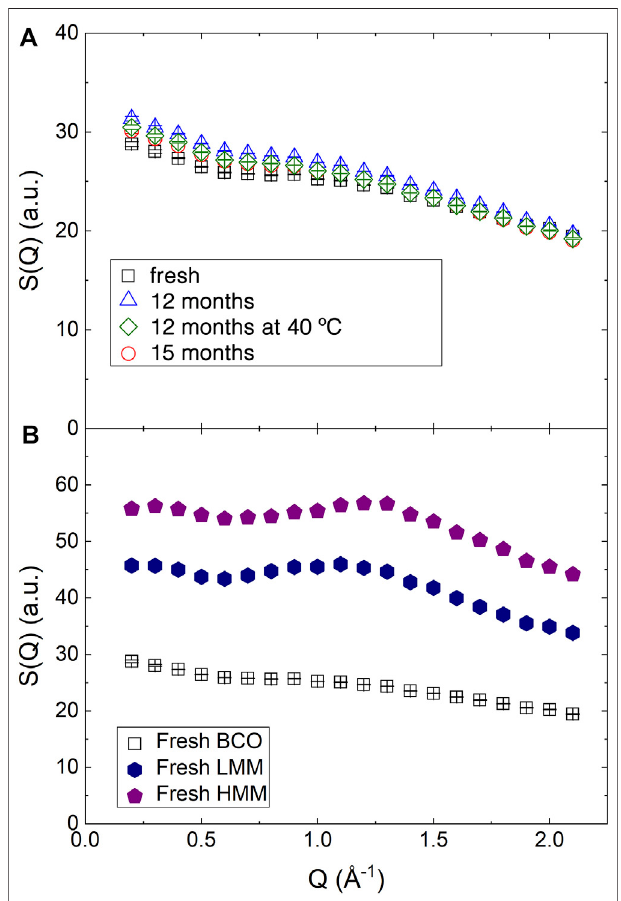
FIGURE 3 | Structure factor as obtained integrating the QENS spectra collected on IN5 over E (see Eq. 3 ). (A) BCO at four aging stages. (B) The structure factor of fresh BCO is compared to the structure factor of the fresh low and high molecular mass lignin fractions.